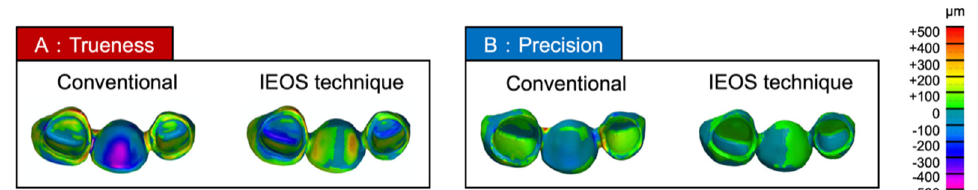
Figure 8. ( A ) Trueness: STL data of provisional and definitive restorations were superimposed by software. ( B ) Precision: STL data of each definitive restoration were superimposed on the software. Table 1. Mean ± SD values and statistical analysis of accuracy (trueness and precision).